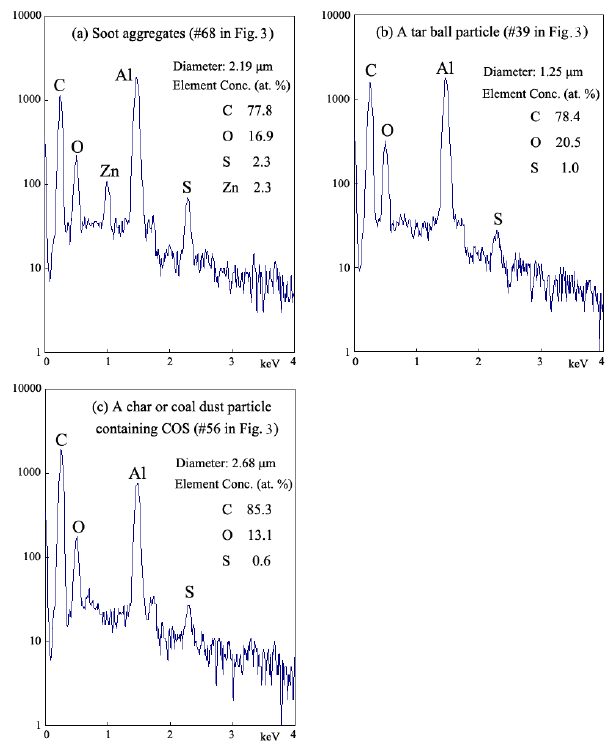
Fig. 4. X-ray spectra and atomic concentrations of carbon-rich particles (Al X-ray peaks are from collecting substrates).